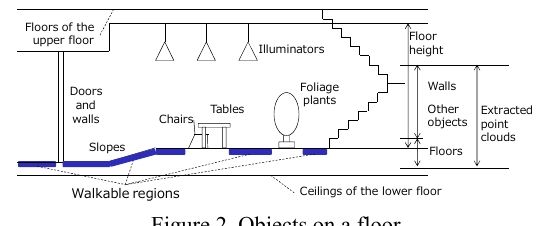
Figure 2. Objects on a floor